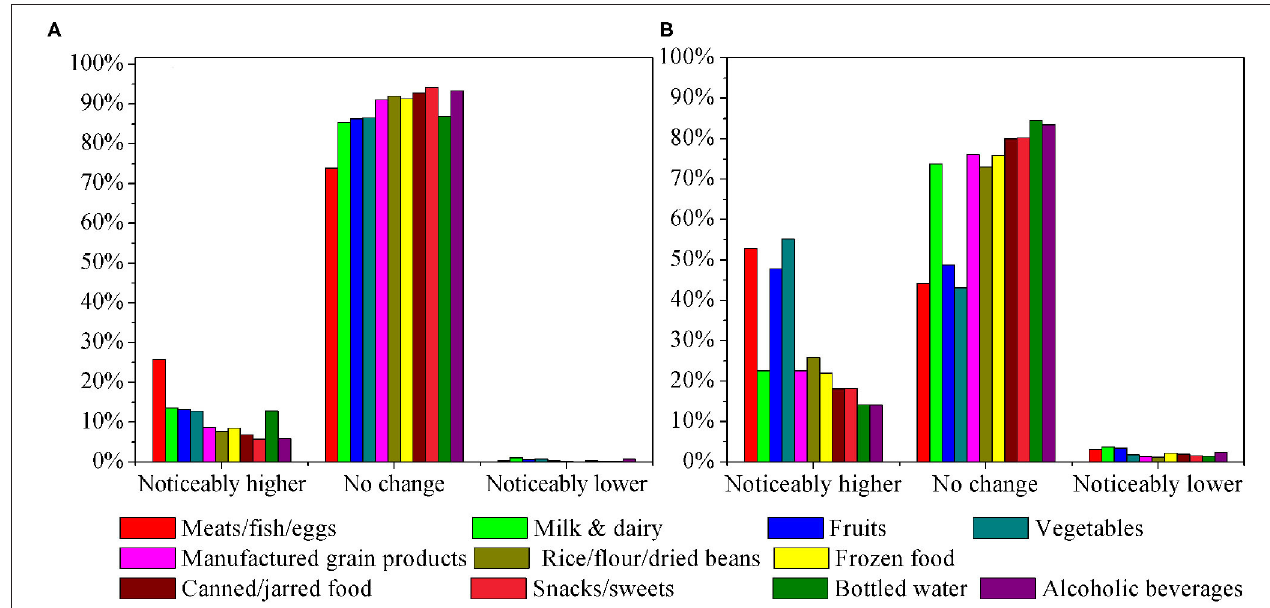
FIGURE 5 | Food price change during as compared to before the COVID-19 pandemic, according to U.S. (A) and Chinese (B) survey participants when grocery-shopping. Proportionally, noticeably higher prices were reported by more Chinese than U.S. participants ( P < 0.001) for all food types, particularly meats/fish/eggs, fruits, and